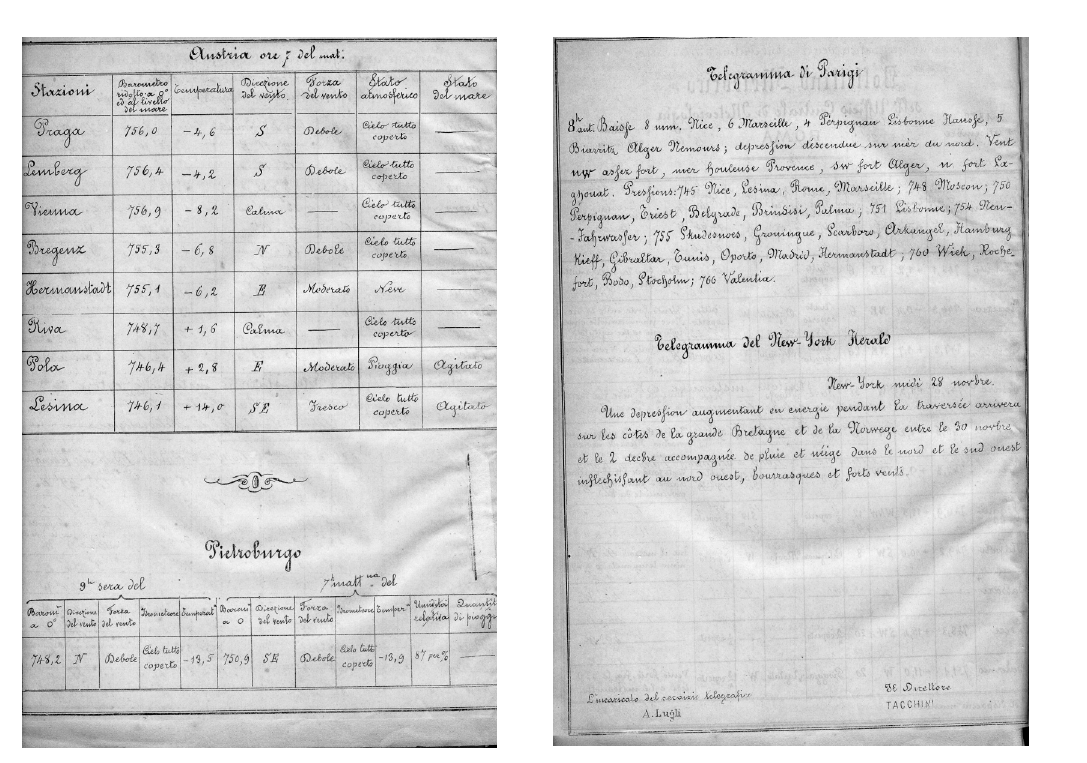
Fig. 3. Bollettino Meteorico first issue pag. 2. Fig. 4. Bollettino Meteorico first issue pag.